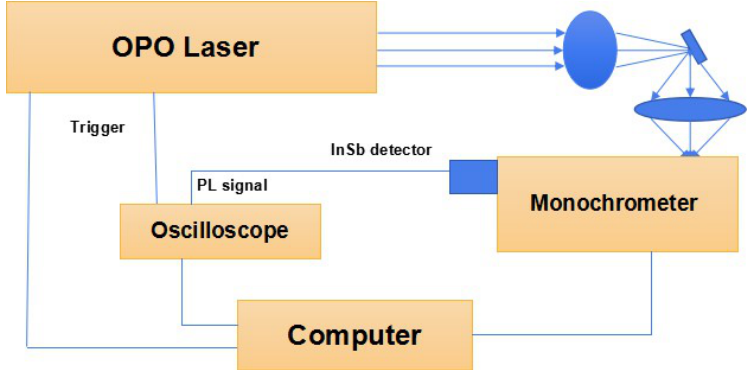
Figure 6. The Schematic of the test of fluorescence lifetime.